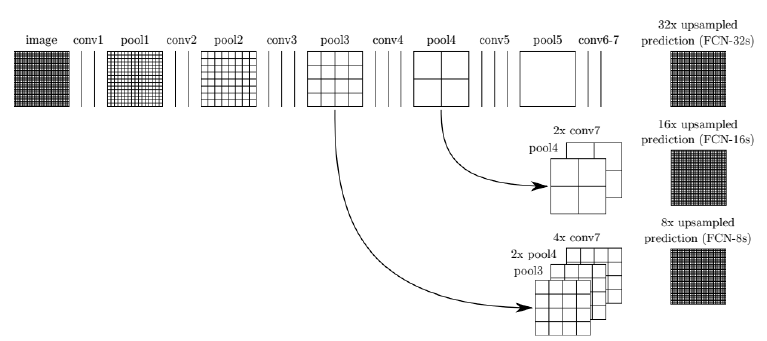
Figure 3. Illustration of the FCN